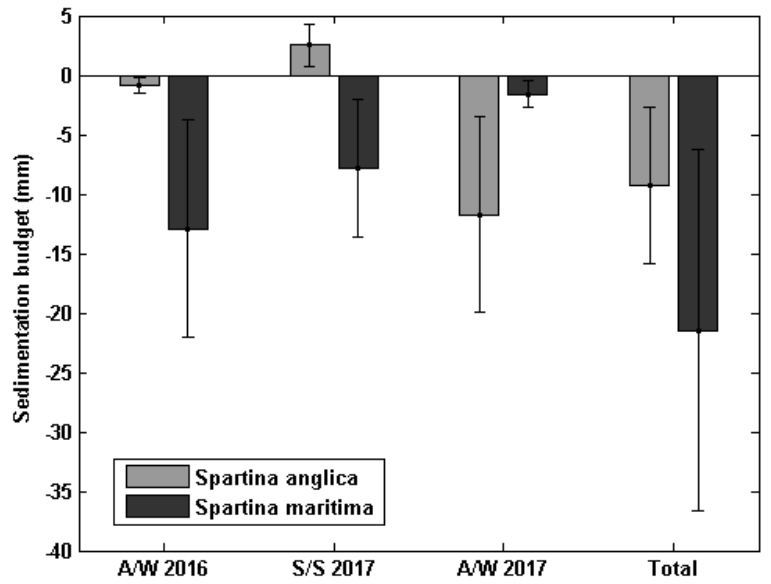
Figure 4. Sedimentation budget (mm) per season (A/W—autumn/winter and S/S—spring/summer) estimated from the difference in the bed level at the beginning and at the end of each season and total budget estimated from the difference in bed level between the beginning and the end of the survey. Negative values indicate erosion and positive values indicate accretion. Error bars represent standard